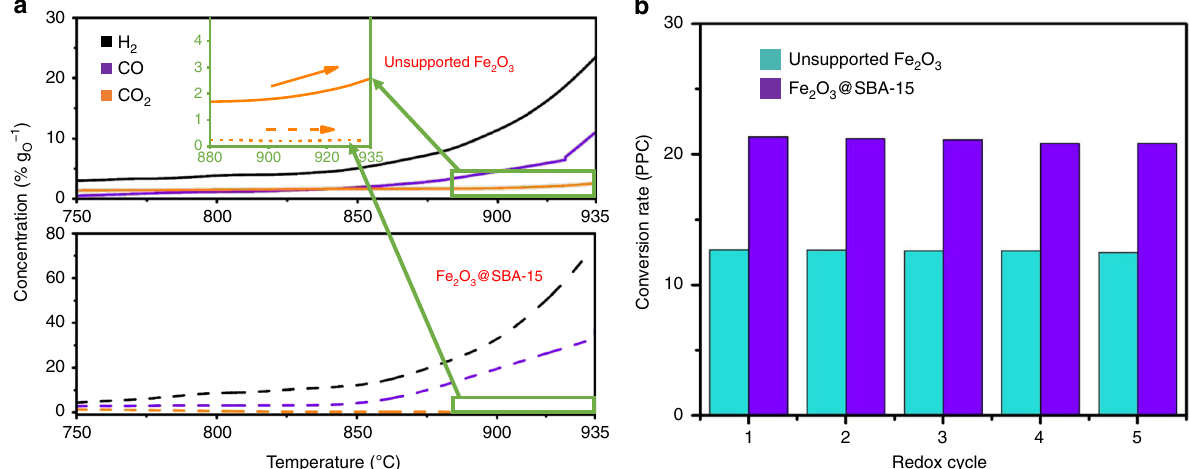
Fig. 3 Reactivity and selectivity comparison between Fe 2 O 3 @SBA-15 and bulk Fe 2 O 3 . a Temperature programmed reduction results of Fe 2 O 3 @SBA-15 and unsupported Fe 2 O 3 ; b conversion rate during redox at 800 °C. NATURE COMMUNICATIONS| (2019) 10:5503